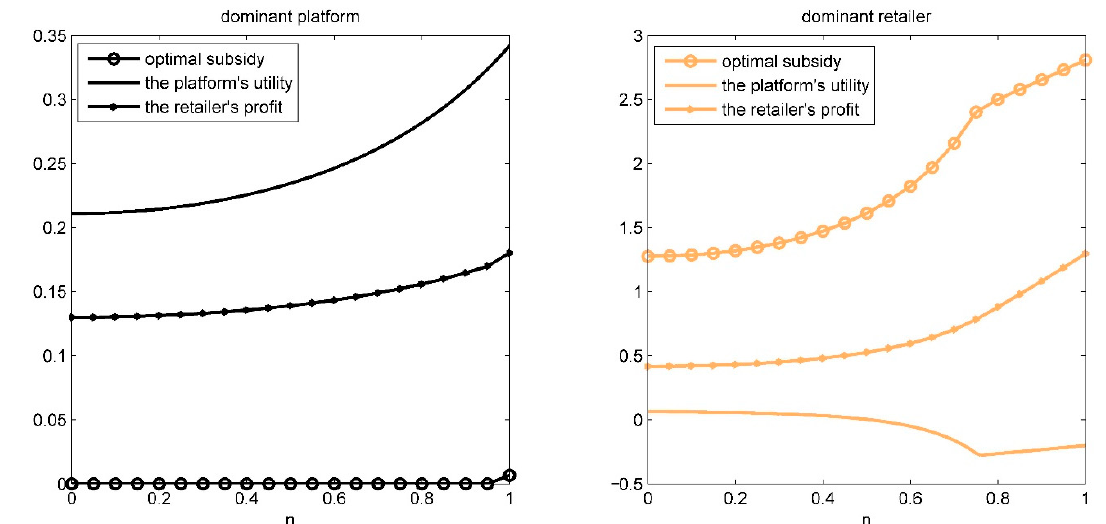
Figure 6. Optimal sales subsidy, the platform’s utility, and the retailer’s profit under different power structures with the change of n .